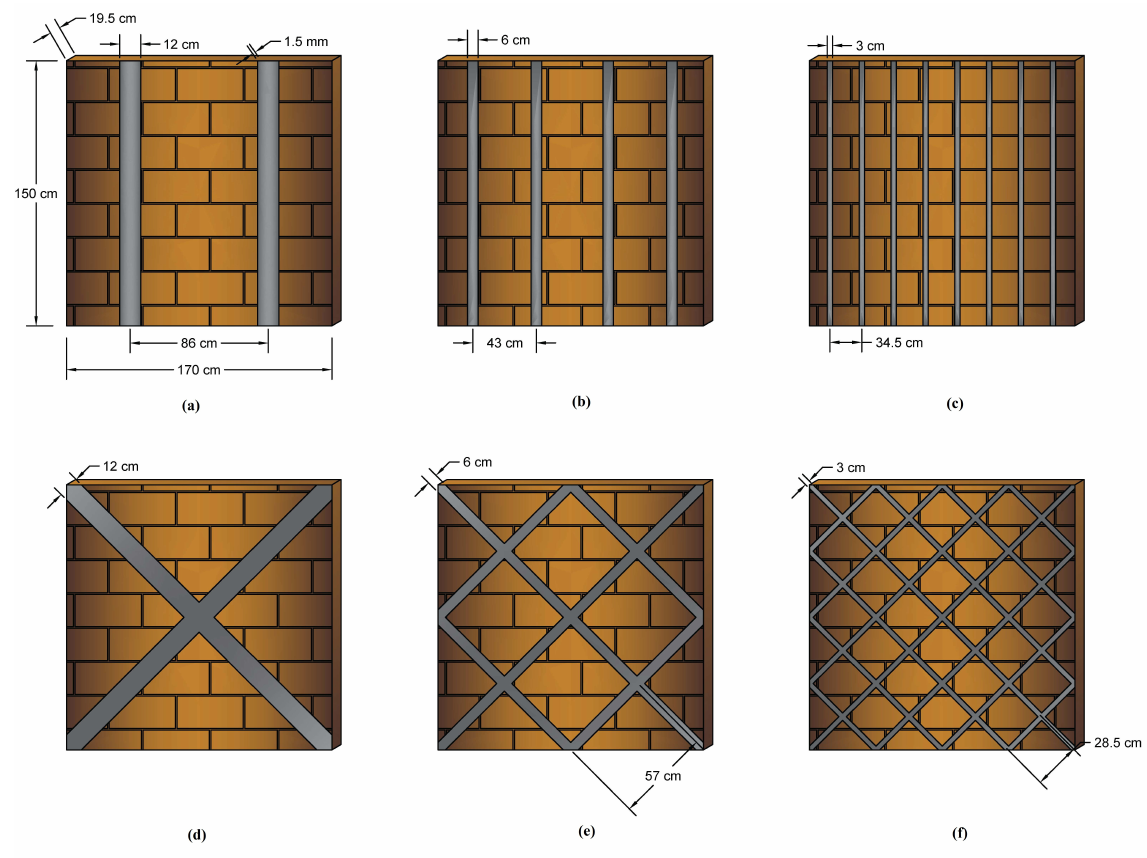
Figure 19. Numerically studied SMA-reinforces walls [81]: ( a ) 2 vertical stripes; ( b ) 4 vertical stripes; ( c ) 8 vertical stripes; ( d ) 2 cross-strips; ( e ) 6 cross-strips; ( f ) 14 cross-strips (figures are taken from